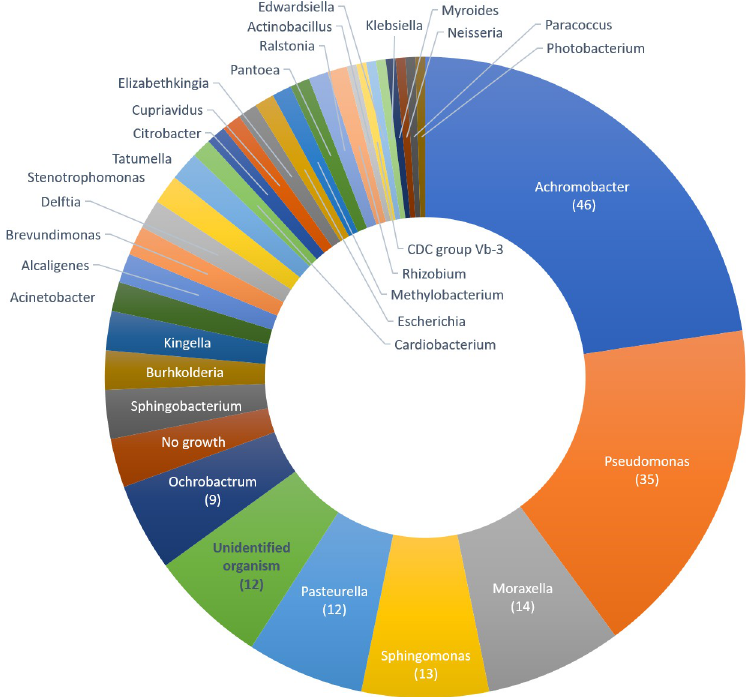
Fig 2. Distribution of previously unidentified isolates at the genus level using BD Phoenix automated identification